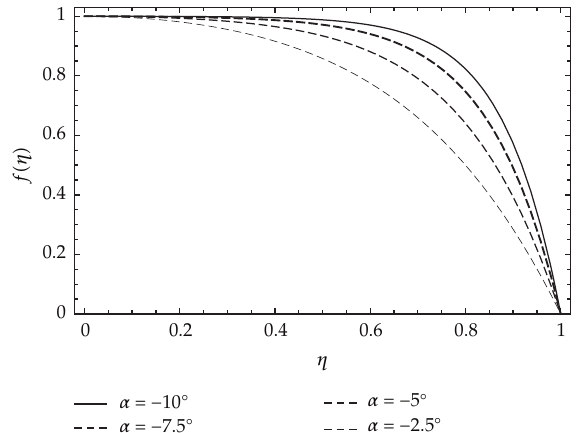
Figure 7: DTM solution for velocity in convergent channels for Re (cid:8) 100 and H (cid:8)